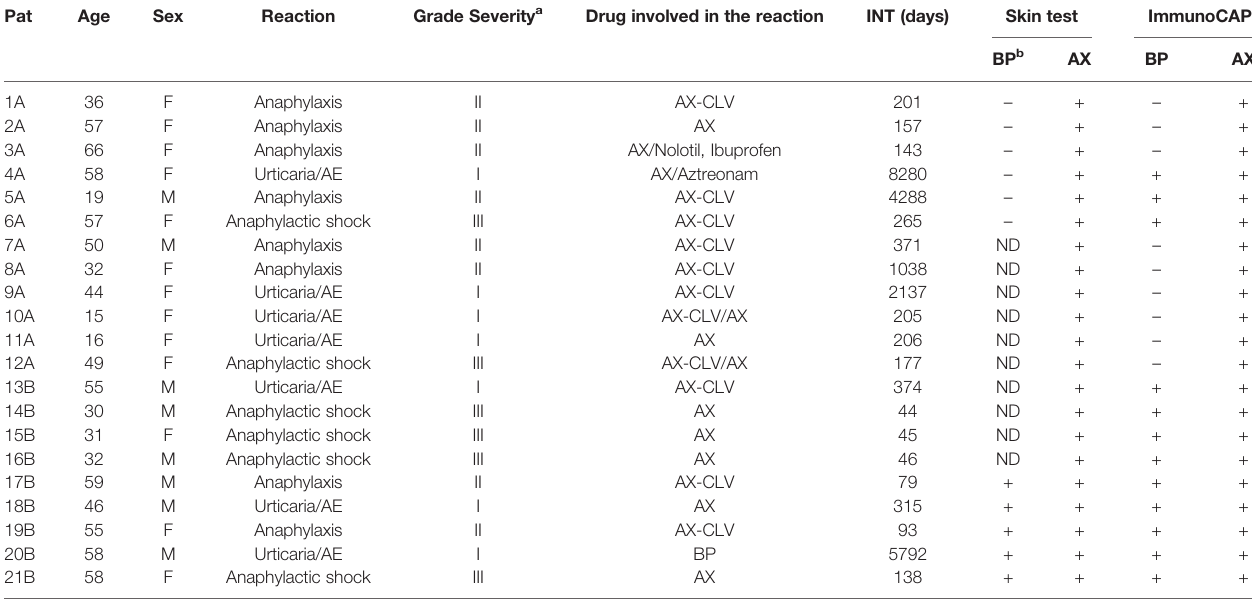
TABLE 1 | Clinical data and classi fi cation (based on skin test and ImmunoCAP results) of patients diagnosed with an immediate allergic reaction to AX included in the study.